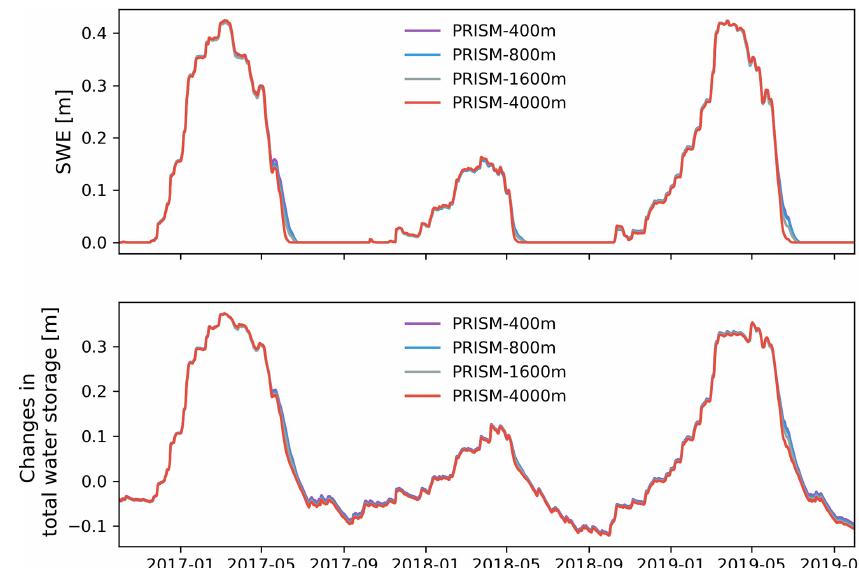
Figure A10. Simulated watershed average SWE and changes in total water storage under different spatial resolutions of PRISM.